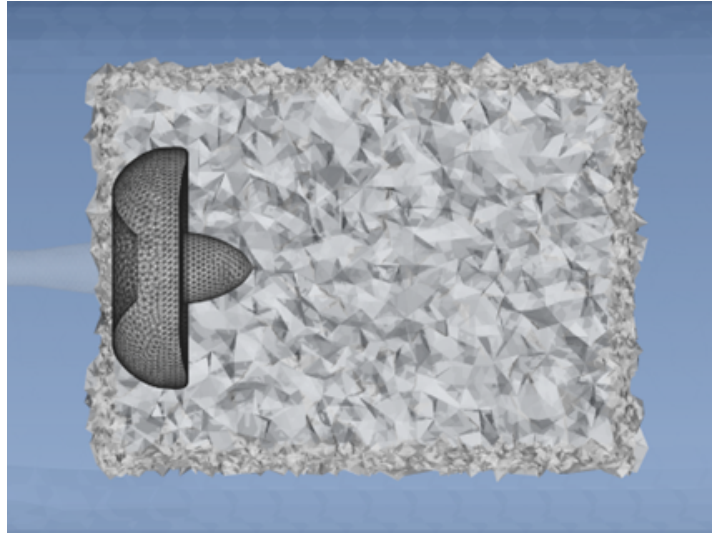
Figure 1. Lighthill surface mesh around the propeller blades and hub, and Lighthill volume mesh around the propeller, and in the wake of the